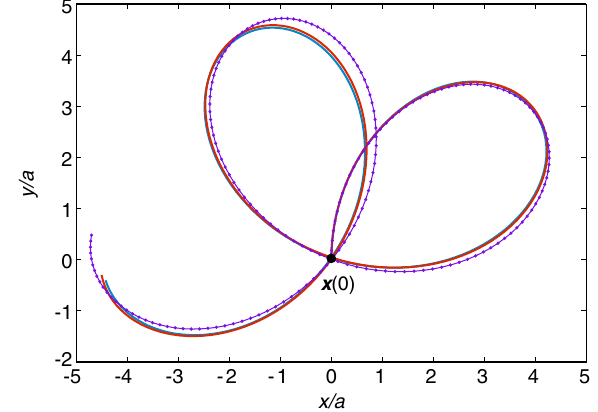
FIG. 3. Comparison between the dynamics of the driven system following the protocol in Eq. (36) (solid red and blue curves) and the dynamics predicted by the effective Hamiltonian (42) (dotted purple curve). Shown is the center-of-mass trajectory in the x - y plane for time t ∈ ½ 0 ; 100 (cid:2)ð 1 =J Þ . For all simulations, a Gaussian wave packet is initially prepared around x ð 0 Þ ¼ 0 with a nonzero group velocity along the þ y direction. The blue and red curves correspond to different initial phases of the driving sequence: The blue (respectively, red) curve is obtained by starting the sequence ˆ ˆ ˆ H A ¼ ¯ p 2 =m (cid:4) (respectively, ˆ H 0 − A ¼ ¯ p 2 =m (cid:4) ). We (36) with 0 þ x y set the values κ ¼ 10 and T ¼ π = 80 ð 1 =J Þ , such as to fulfill the low-flux condition Φ ¼ 1 = 128 ≪ 1